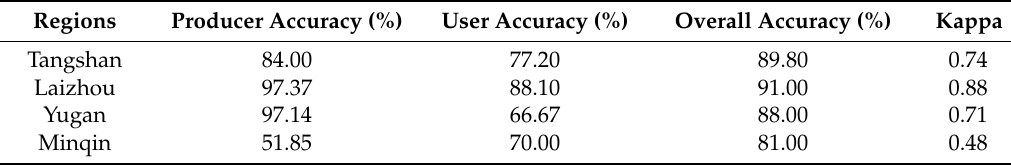
Figure 11. The extraction results of Minqin ( a ), Laizhou ( b ), and Yugan ( c ). Table 6. Accuracy assessment of the four areas.